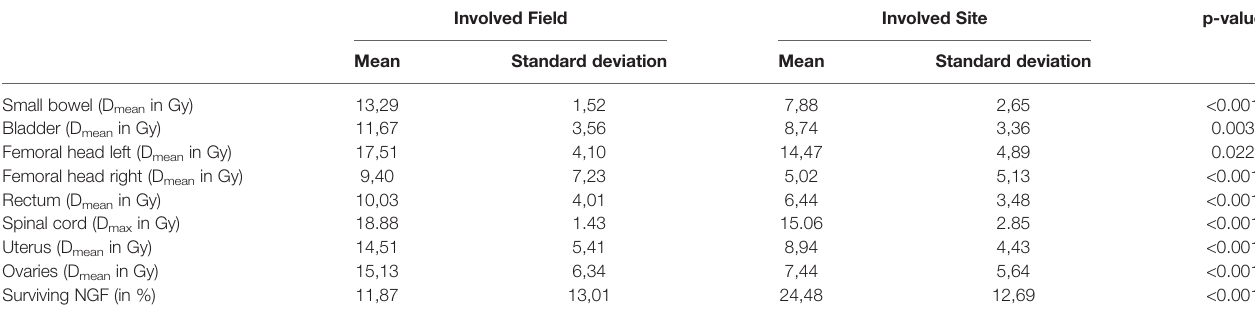
TABLE 5 | Organs at